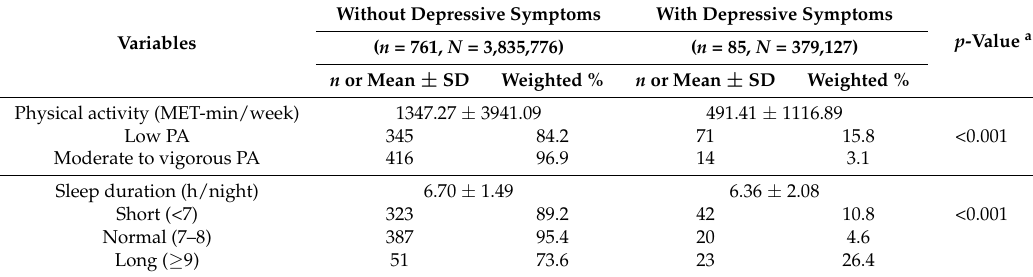
Table 2. Comparison of physical activity and sleep duration among hypertension patients with and without depressive symptoms ( n =